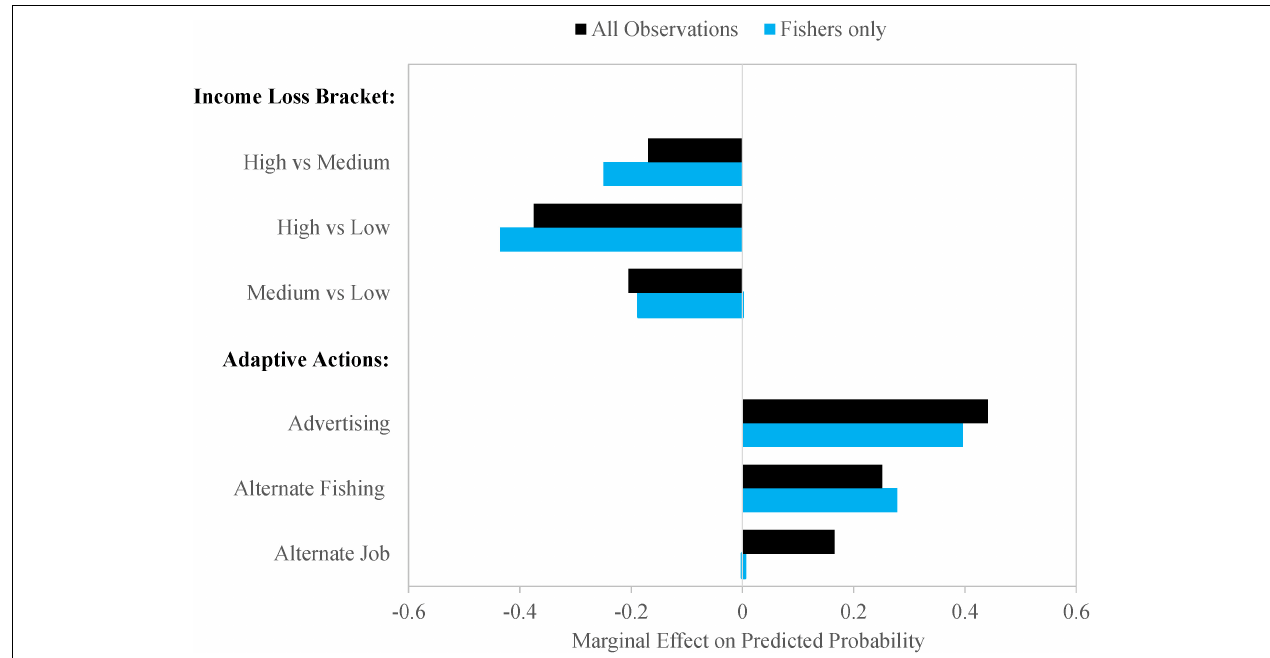
FIGURE 3 | The effect of income loss level and adaptive actions on the probability of income loss recovery. All effects are statistically significant ( p < 0.1) apart from alternate job for